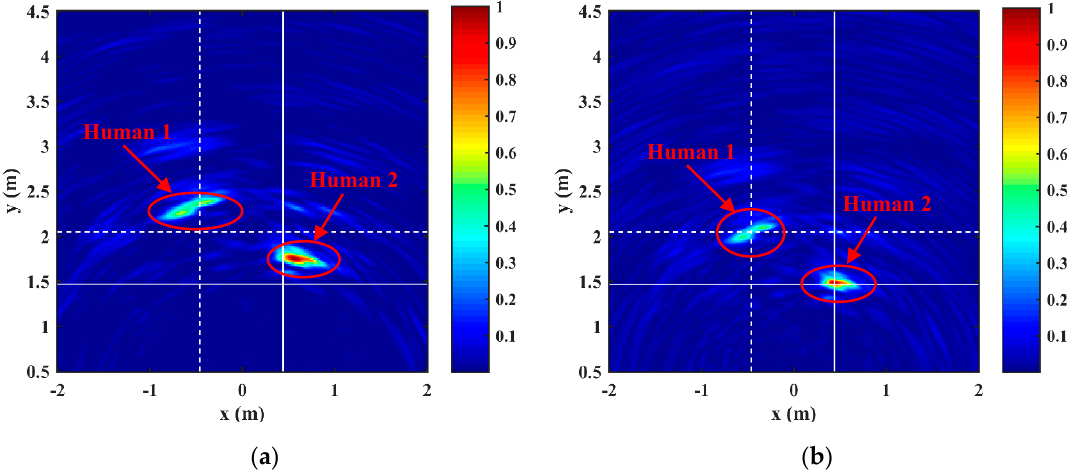
Figure 19. 2D through-wall imaging results for two humans behind a wall: ( a ) Imaging directly by the CC-TDBP algorithm with background removal; ( b ) Imaging by improved the CC-TDBP algorithm considering the presence of the wall.